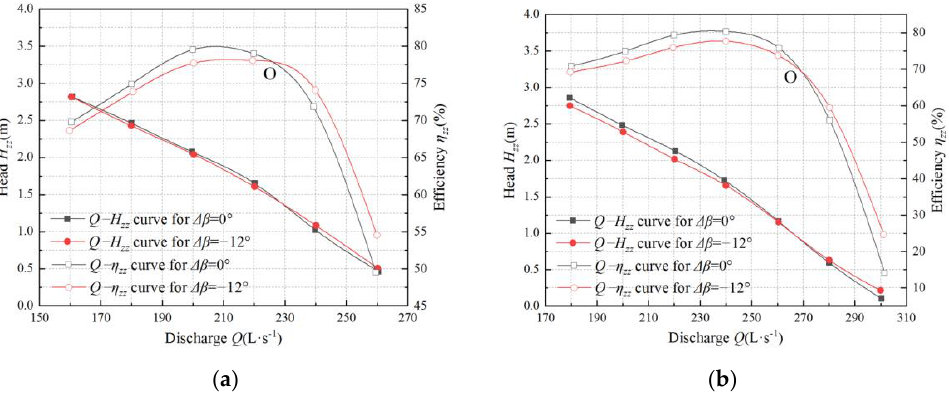
Figure 10. Comparison of energy performance under ∆ β of 0 ◦ and − 12 ◦ in pump device, ( a ) α = − 2 ◦ , ( b ) α = 0 ◦